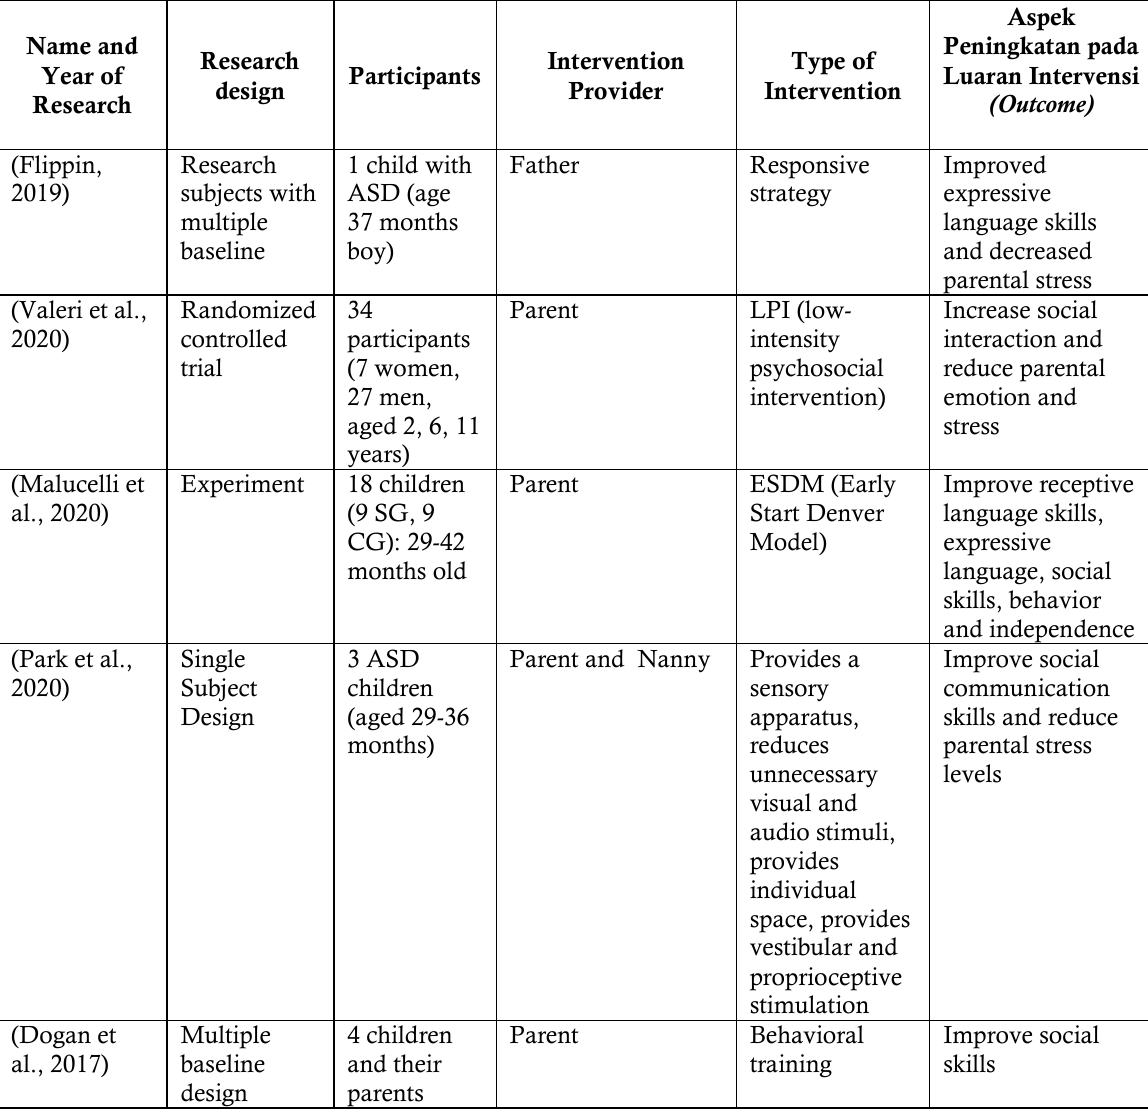
Table 1 <Characteristics of Family Studies and Intervention